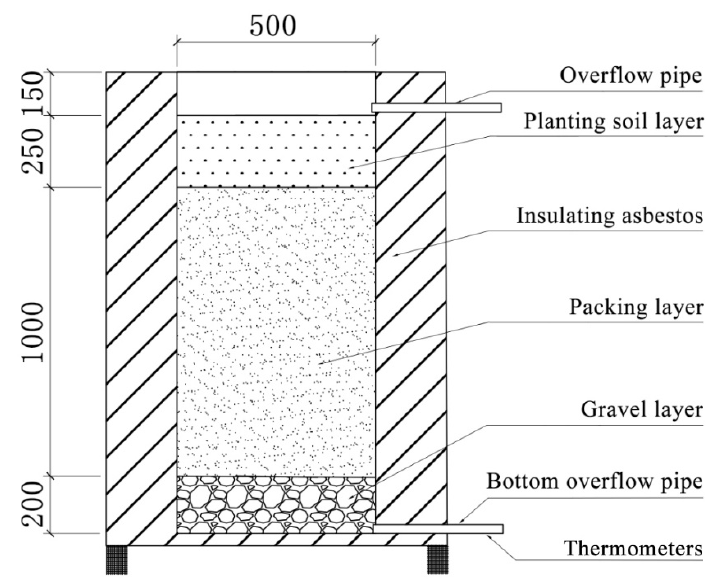
Figure 1. The experimental bioretention schematic diagram.